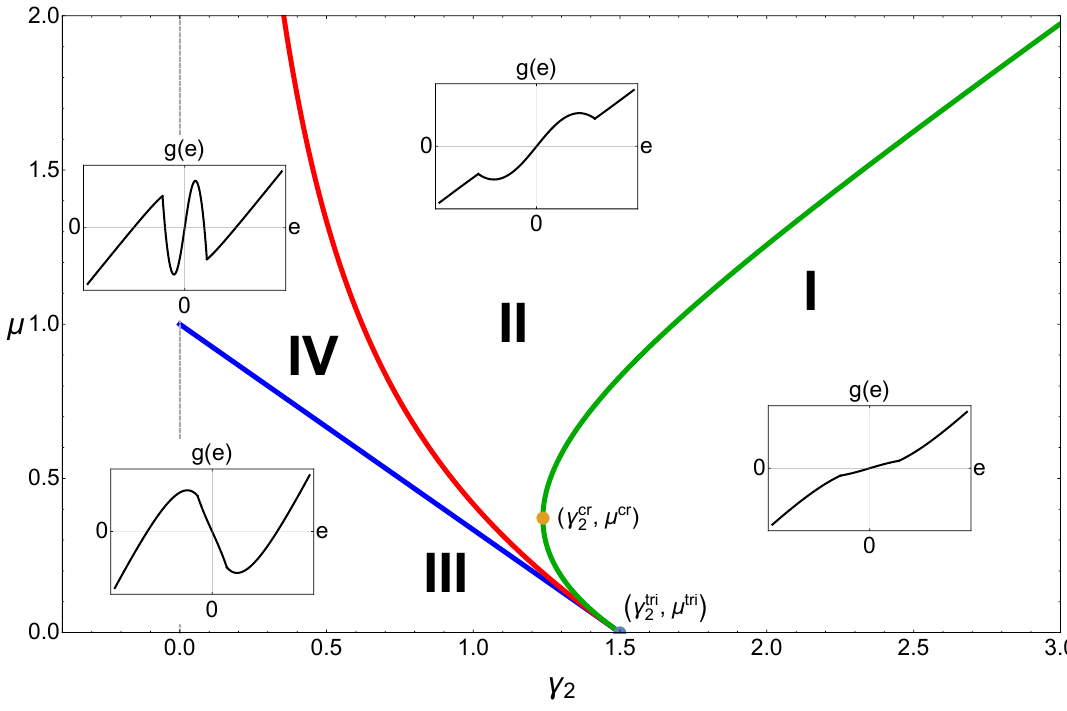
Figure 12 . Phase diagram of the derivative of the potential, v 0 ( e ) = g ( e ) , in the ( γ 2 , µ ) plane. The insets show the different shapes of the function g ( e )